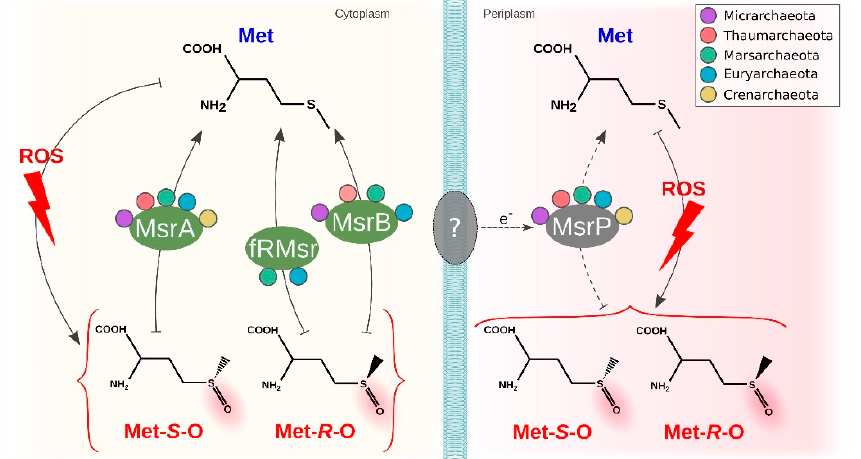
Figure 6. Methionine sulfoxide reductases in acidophilic archaea. Methionine is oxidized by ROS to two different stereospecific forms, where Met-S-O is reduced by MsrA, Met-R-O is reduced by MsrB and fRMsr at the periplasm and both forms are reduced by MsrP obtaining electrons from an unknown source protein. The presence of the proteins in each phylum is represented by circles (purple for Micrarchaeota, pink for Thaumarchaeota, green for Marsarchaeota, blue for Euryarchaeota and yellow for Crenarchaeota).